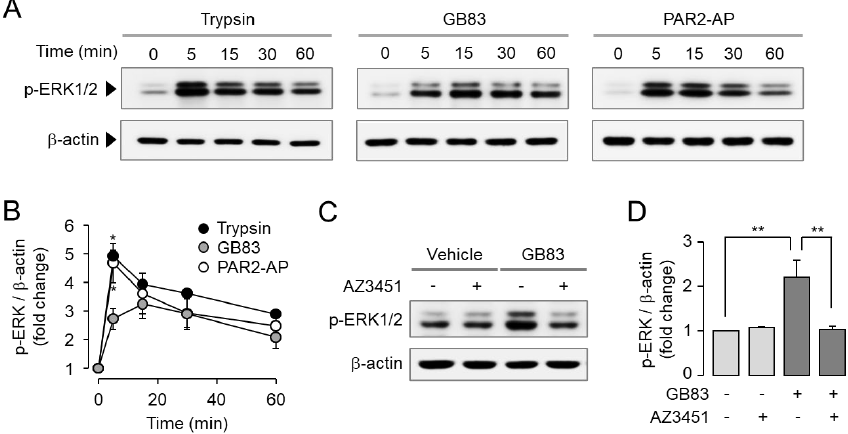
Figure 3. GB83 induced phosphorylation of ERK1/2 through PAR2 activation in HT-29 cells. ( A ) Representative immunoblots of ERK1/2 phosphorylation. PAR2 stimulated by trypsin (30 U/mL), GB83 (30 µM), and PAR2-AP (30 µM). ( B ) p-ERK1/2 band intensity was normalized to β -actin (mean